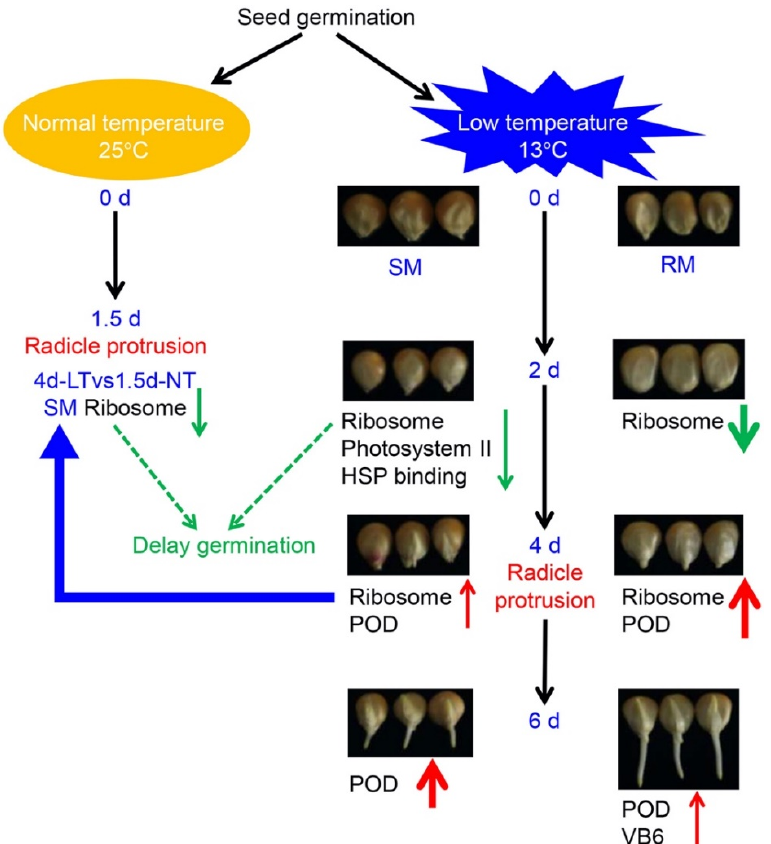
Figure 6. A possible network of the dynamic changes in seed germination under low-temperature stress in maize. The red and green arrows indicate upregulation and downregulation of genes, respectively. The thickened arrows indicate stronger changes induced by low-temperature stress. The blue arrow means transcriptome analysis of seeds germinated at 13 °C for 4 d compared to seeds germinated at 25 °C for 1.5 d (4d-LTvs1.5d-NT). The dotted lines indicate conjectural regulation.